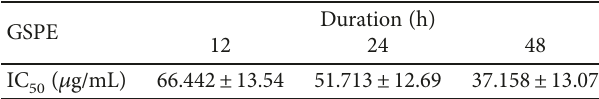
Figure 1: The e ff ect of GSPE on ECA109 survival. The cytotoxicity of GSPE (0 – 400 μ g/mL and 12 – 72 h) was detected by MTT assay. Each column represented mean ± SD of three groups of independent samples. ∗ means P < 0 05 compared with GSPE 0 μ g/mL. Table 2: IC of GSPE over di ff erent treatment 50